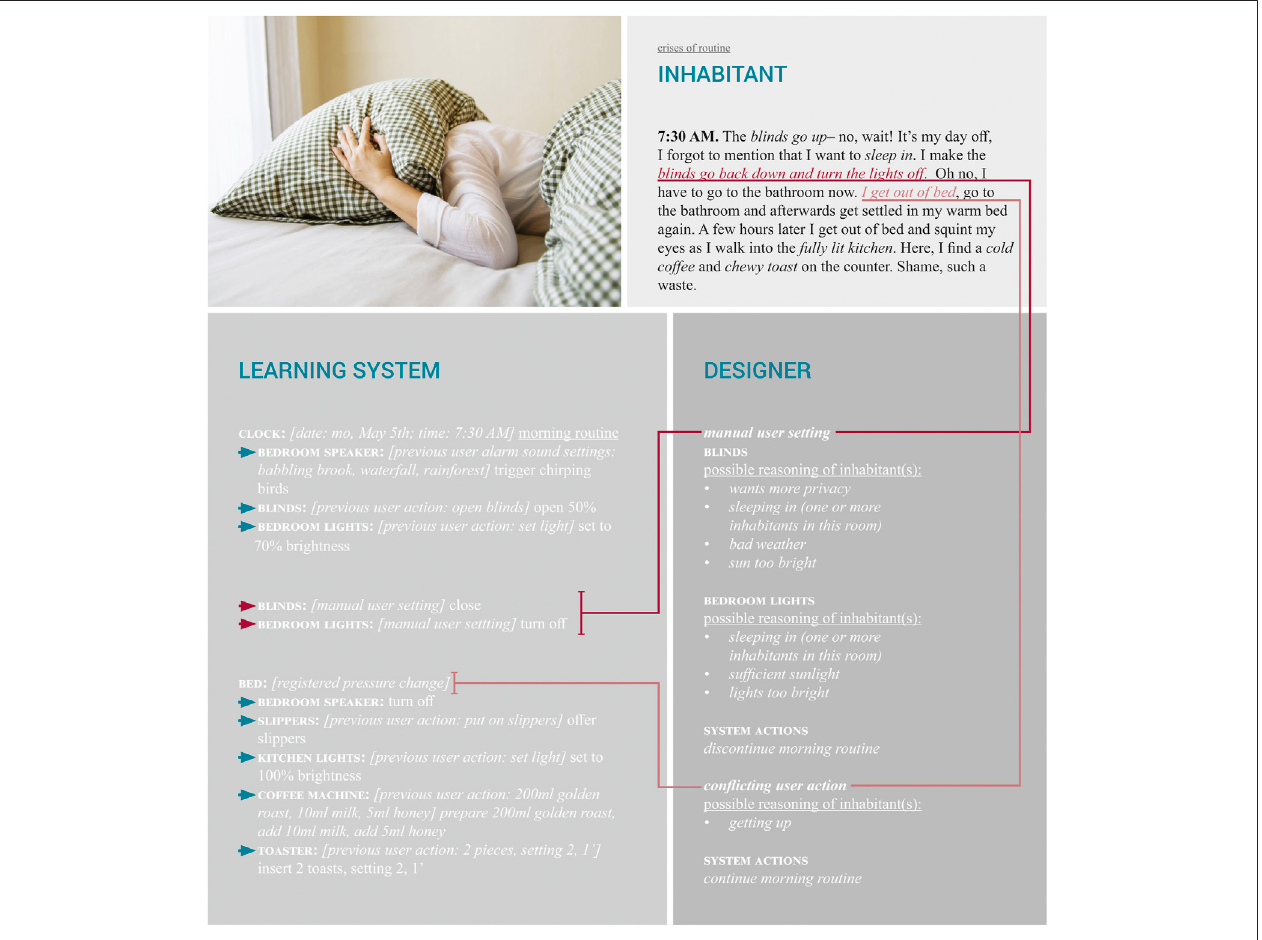
FIGURE 2 | Getting up: crises imaginary (photo by Wuttichaikitcharoen,